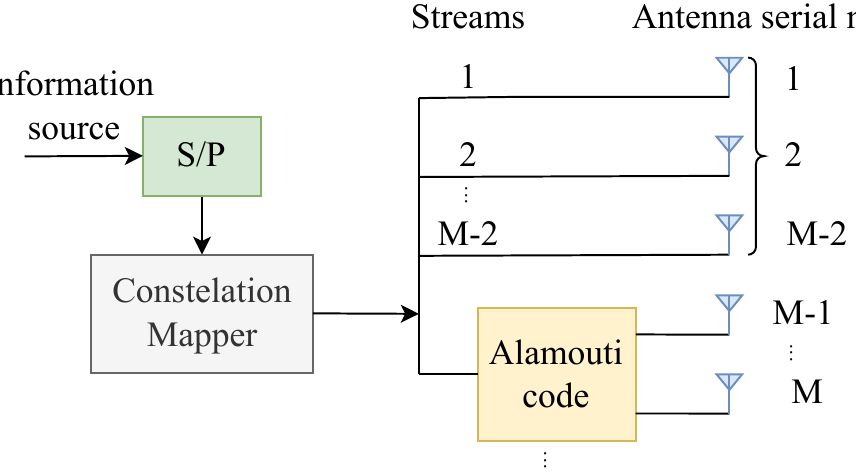
Figure 1. Block diagram for the STBC-VBLAST transmitter with